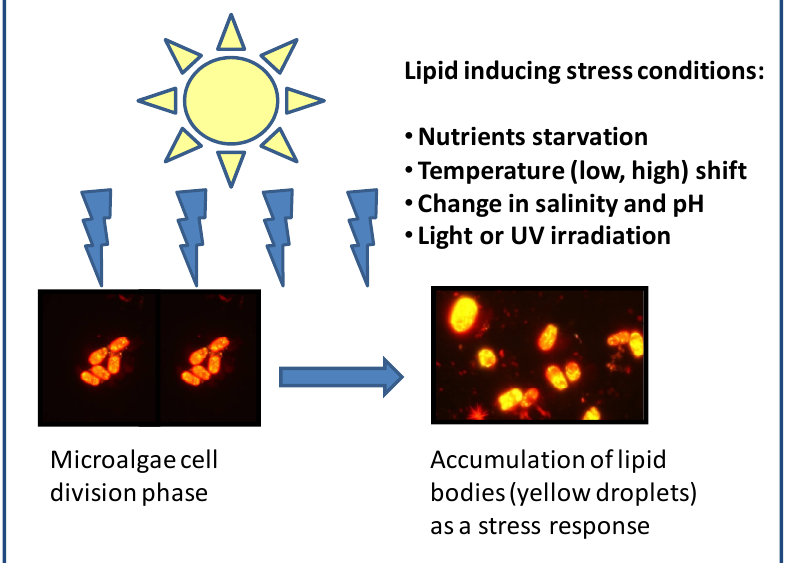
Figure 1. Lipid induction in microalgae under stress